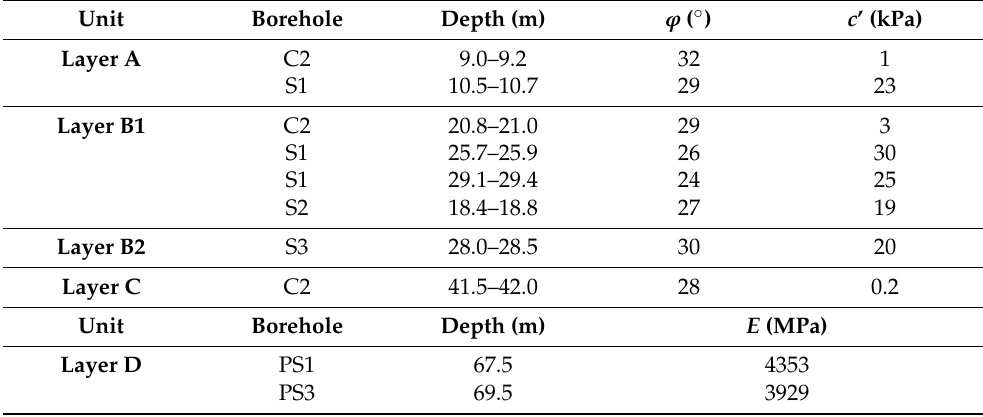
Table 1. Soil parameters obtained from direct shear tests (layer A, B1, B2 and C) and from dilatometer tests (layer D) performed on the materials involved in the landslide